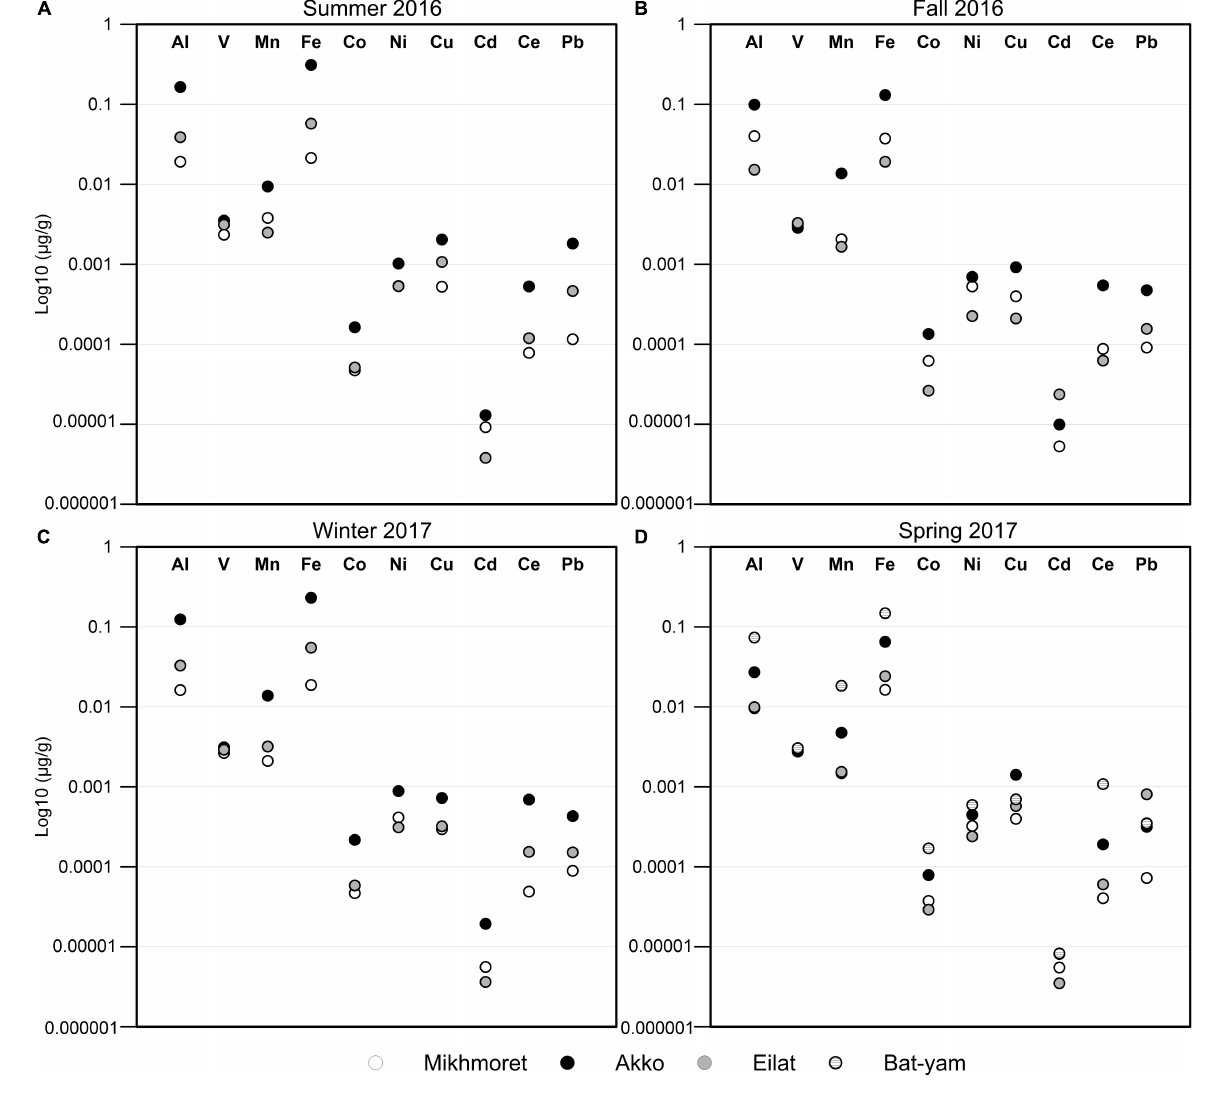
FIGURE 3 | Metal concentrations in seawater samples from Mikhmoret, Akko, Eilat, and Bat-Yam, during the months of the study: summer 2016 (A) , fall 2016 (B) , winter 2017 (C) , and spring 2017 (D) . Metal concentrations are presented on a log 10